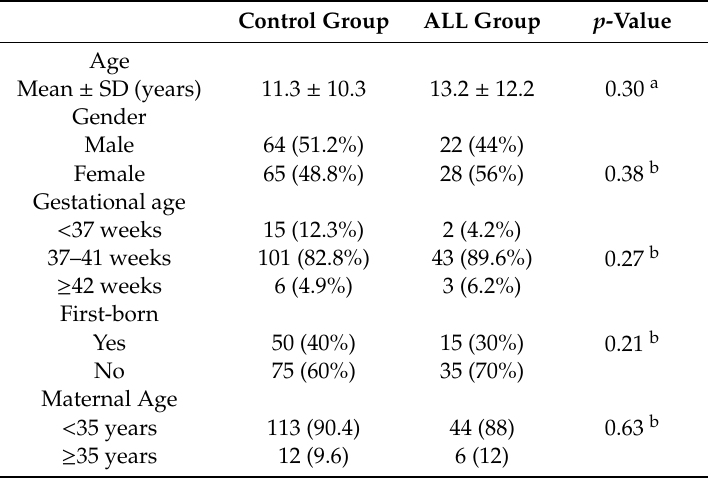
Table 1. Characteristics of patients with acute lymphoblastic leukemia (ALL group) and control group.